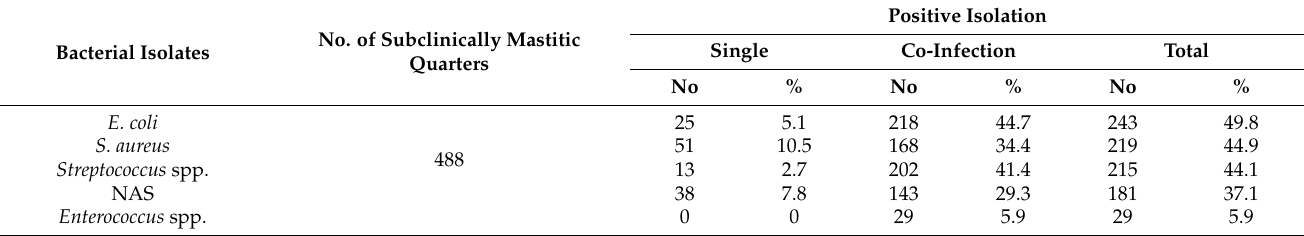
Bacterial Isolates